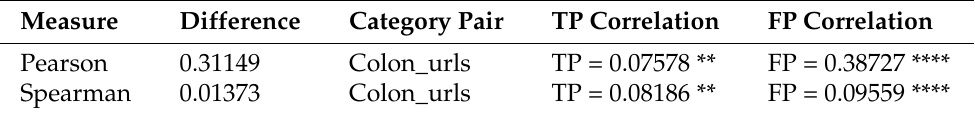
Table 55. Colons and URLs in